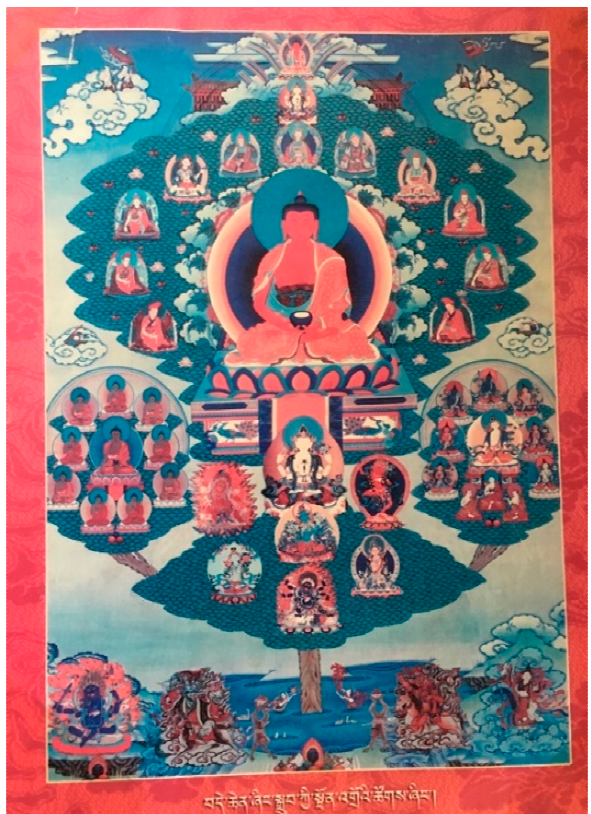
Figure 1. Meditational guide of Amitabha’s Field of Accumulation produced by Lho Lungkar Figure1. Monastery.